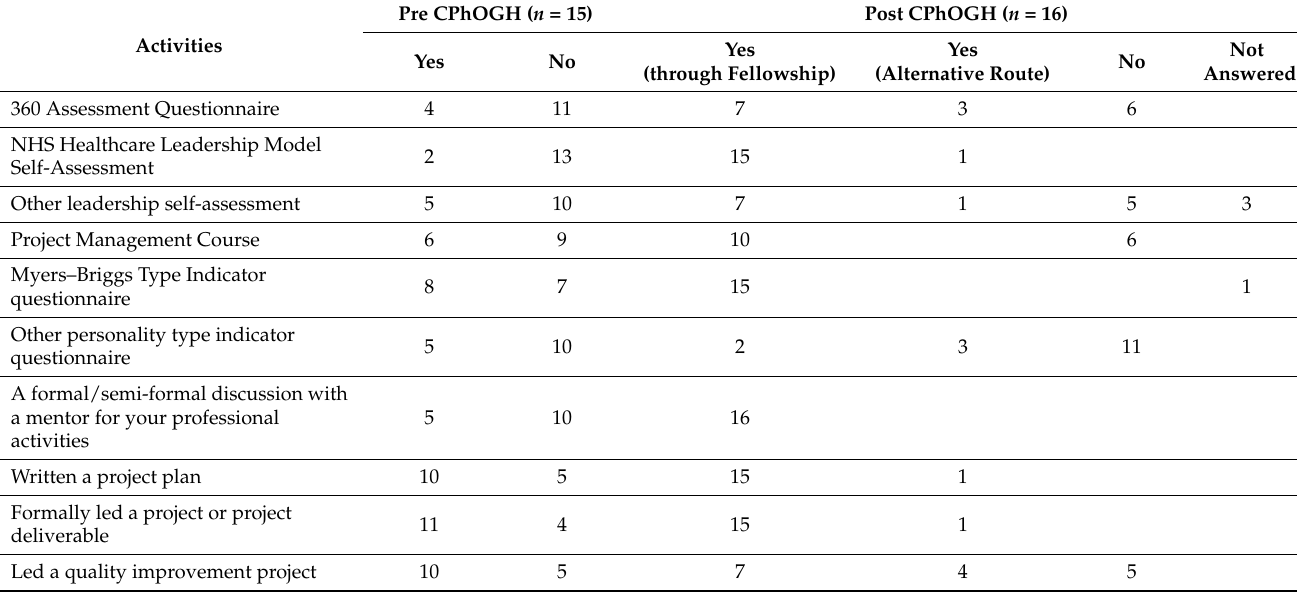
Table 2. Leadership and project management activities experienced by the CPhOGH Fellows pre- and post-CPhOGH Fellowship programme.